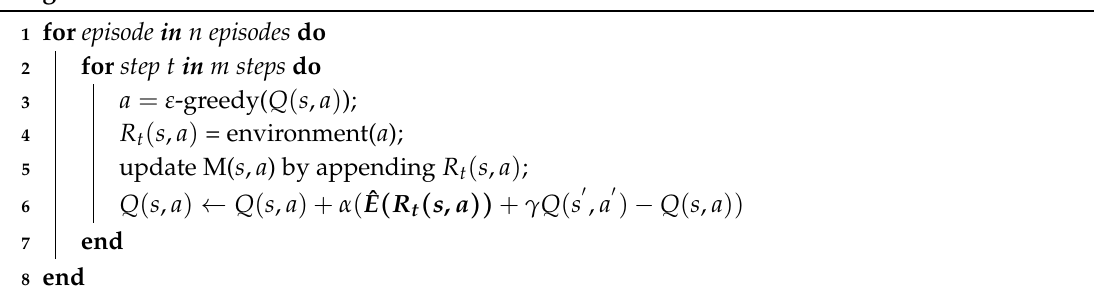
Algorithm 1: Pseudo-Code for e-disRL- and